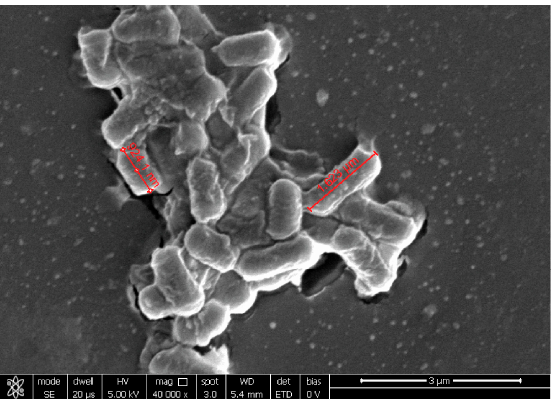
Figure 6. Representative image obtained with SEM of L. plantarum PBS067 and E. coli aggregates. Magnification 40,000×.